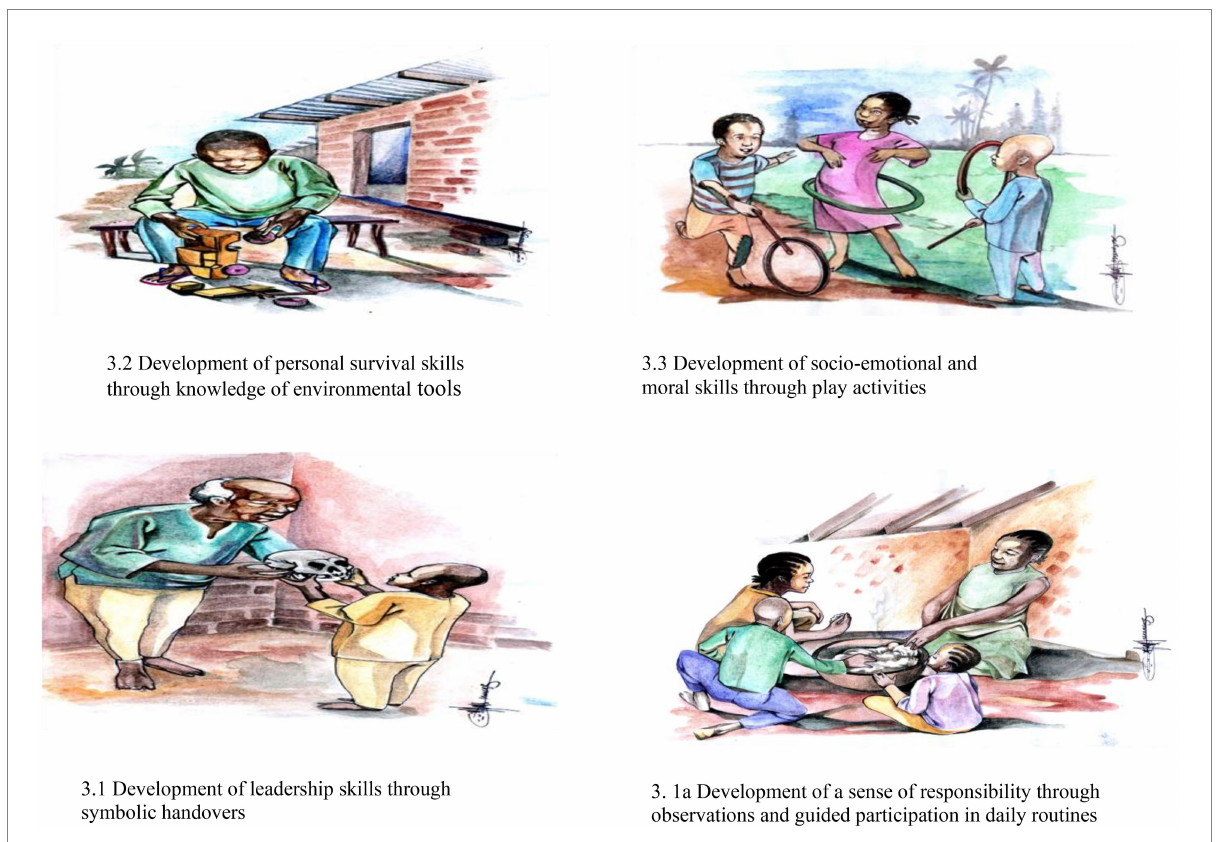
FIGURE 1 Resilient cultural practices for cognitive development. Source: Pictures adapted and drawn from current write-up (Noumsi, 2021, unpublished).